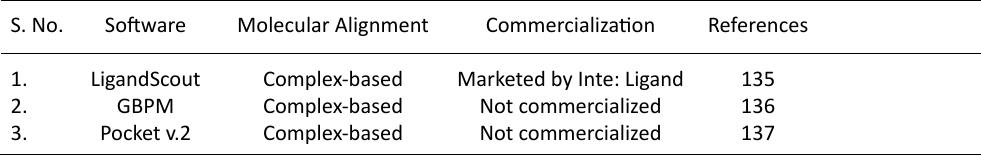
Table 4. Ligand-based pharmacophore modeling software S. No.